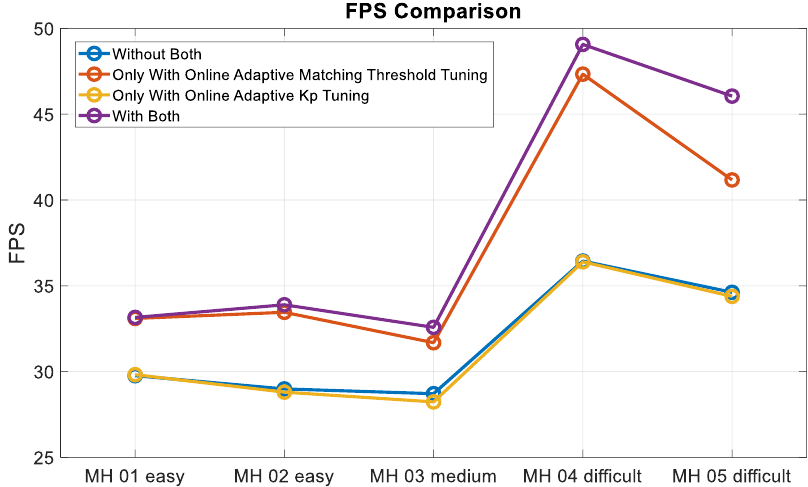
Figure 23. FPS comparison.